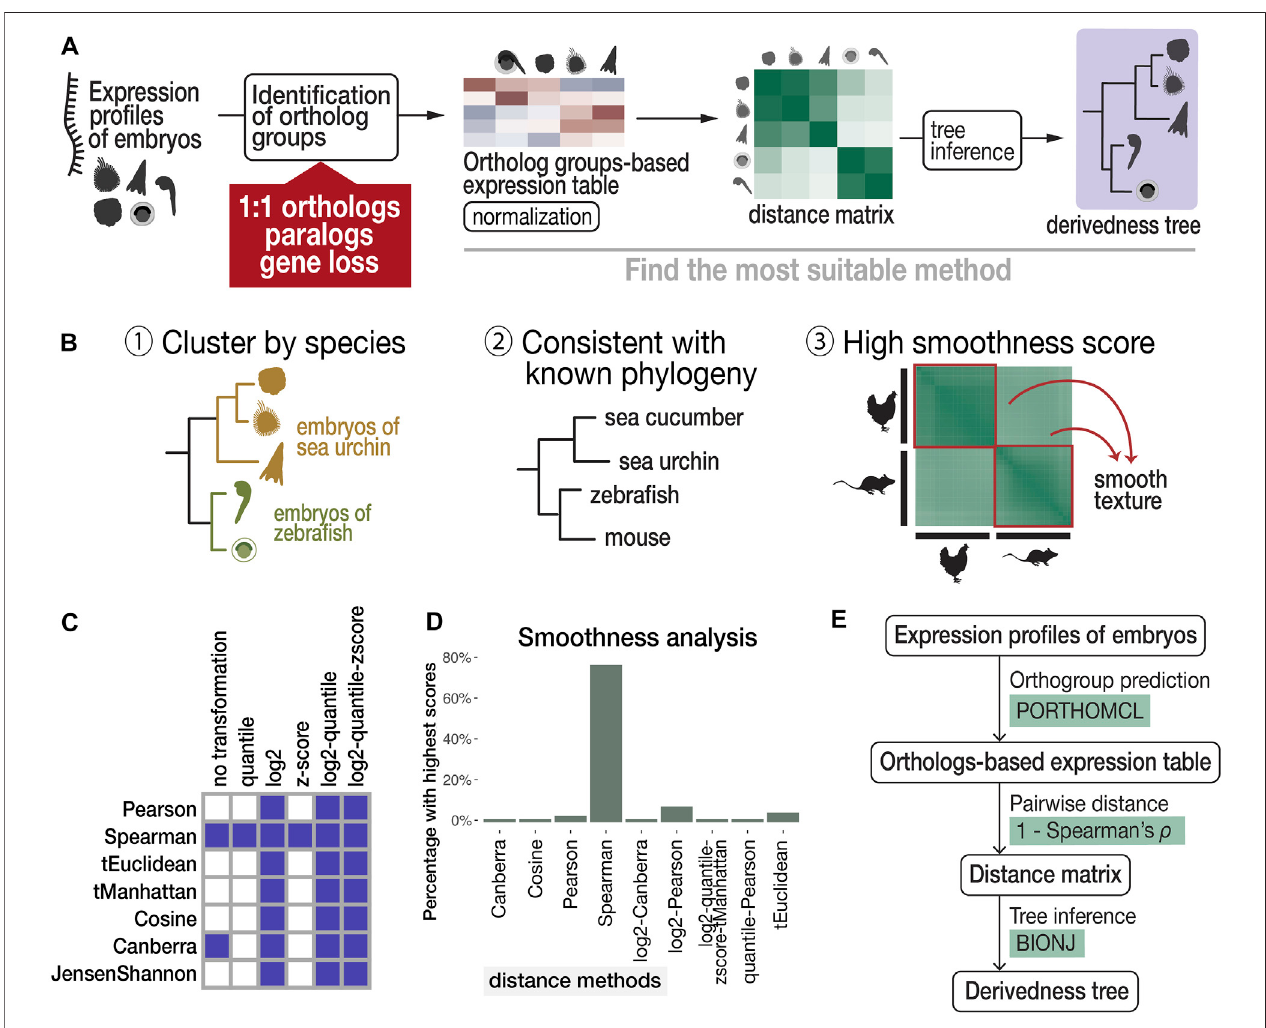
FIGURE 2 | Proposed work fl ow to estimate phenotypic derivedness of embryos using gene expression pro fi les and evaluation of methods. (A) Outline of measuring transcriptomic derivedness. Whole embryonic transcriptomes from different species were compared using the expression levels of ortholog groups,which consider not only 1:1 orthologs but also paralogs and genes that are presumably lost in speci fi c lineages. Derivedness index of each embryo was de fi ned as the total branch length from the putative common ancestral node on the inferred tree. (B) Criteria for selecting the suitable method for quantifying derivedness of embryos. These include: [1] clusters samples